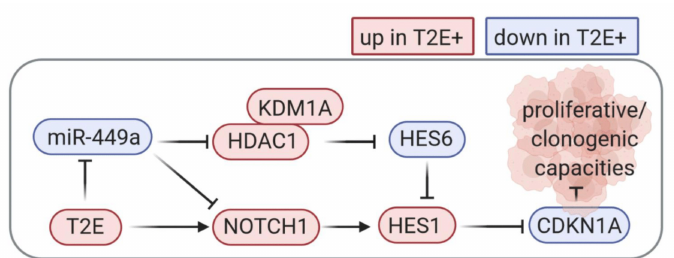
Figure 8. Proposed regulatory network of NOTCH signaling in T2E+ PCa. Genes with blue colored background are downregulated, and genes with red colored background are upregulated, respectively, in LNCaP T2E and TCGA-PRAD derived data. Arrows and stop bars define activation and